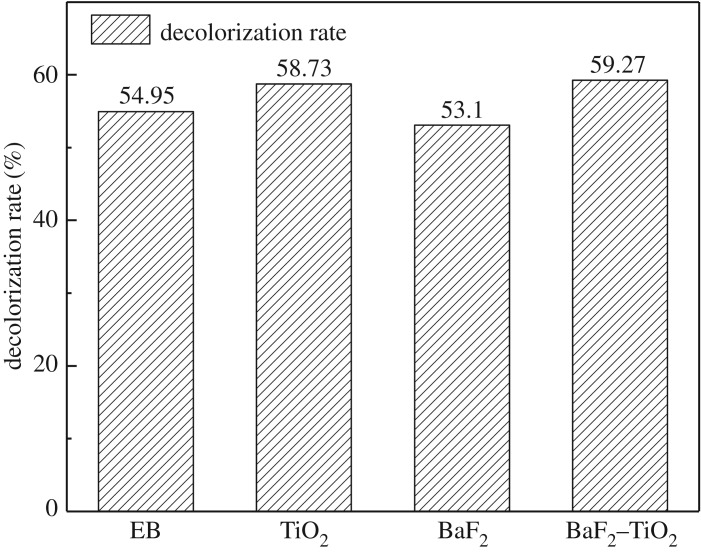
Effect of different catalysts on the decolorization rate of methyl orange solutions irradiated with an EB (CBaF2, CP25: 1 g l−1; C0.75-BaF2–TiO2: 1.75 g l−1).